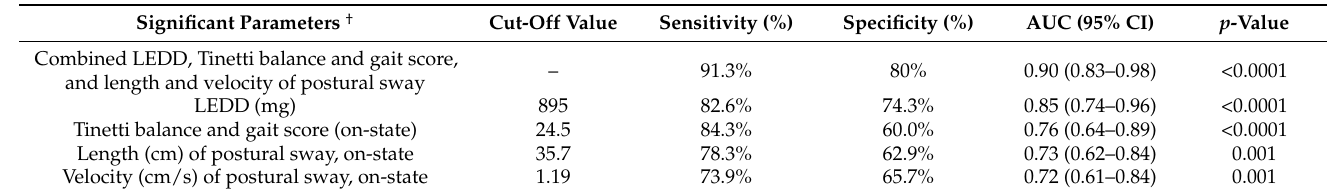
Table 5. Diagnostic accuracy for predicting prospective falls, using receiver-operating characteristic curve analysis.